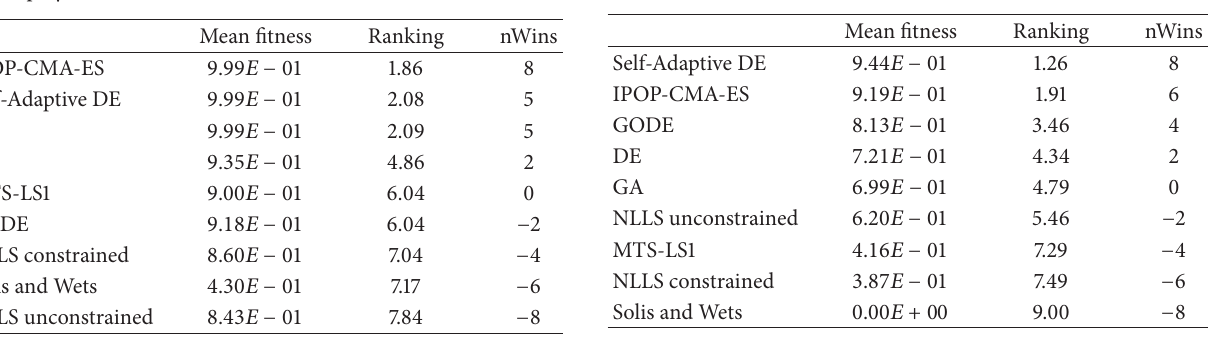
Table5:Meanfitness,averageranking,andnumberofwins(nWins) in pair-wise comparisons with the other algorithms on the 4-by-4 degree polynomial rational function.